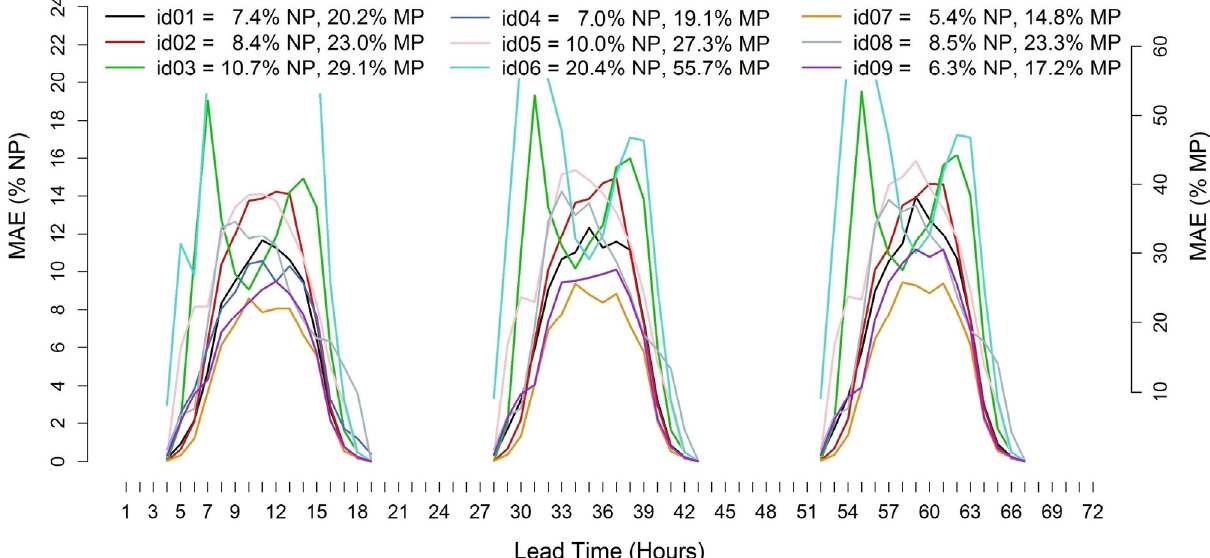
Figure 8. Error trends of the 1–72 h ahead solar power forecasts starting at 0 UTC for the Catania test case ( MAE / NP % and MAE / MP %).